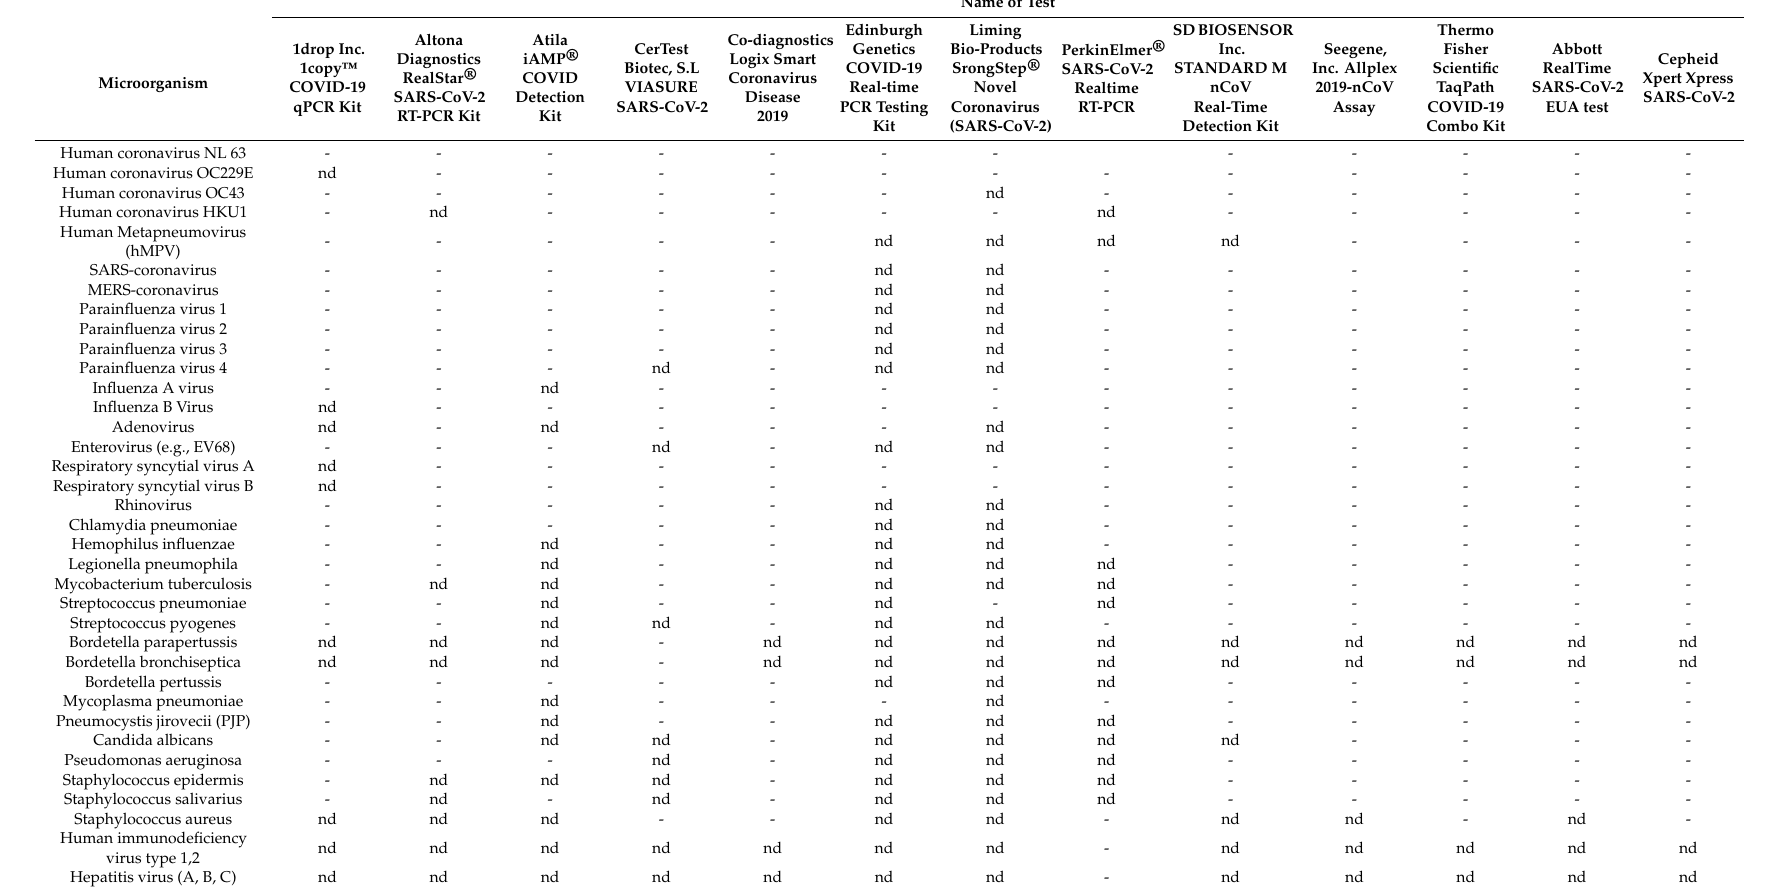
Table 3. The analytical specificity of the test with respect to cross reactivity with other pathogens than Severe Acute Respiratory Syndrome Coronavirus 2 (SARS-CoV-2) (updated 13 June 2020, online sources according to manufacturers’ specification).